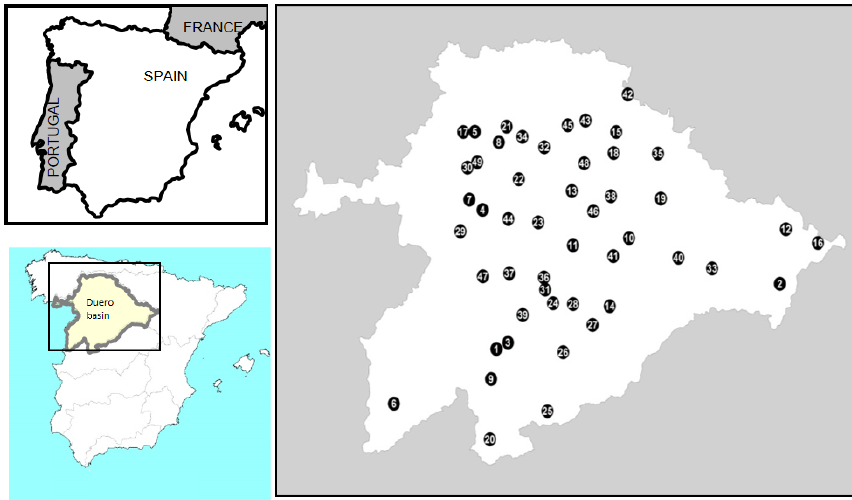
Figure 1. Location of study area. The point with the number indicates the location of the agrometeorological stations according to Table 1.